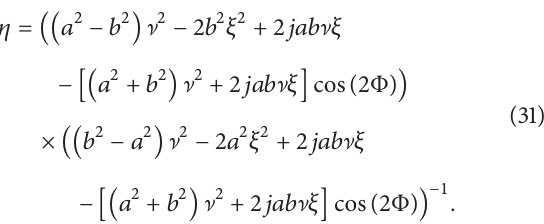
= 1.5 , and refractive II